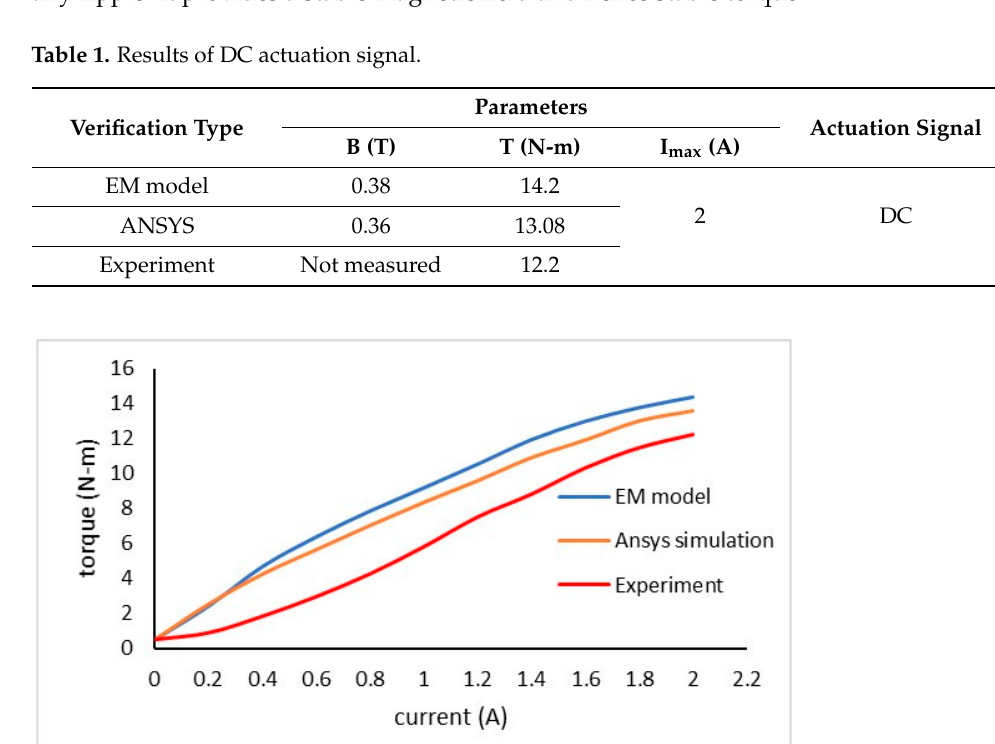
Figure 7. Torque performance of MR brake with DC actuating